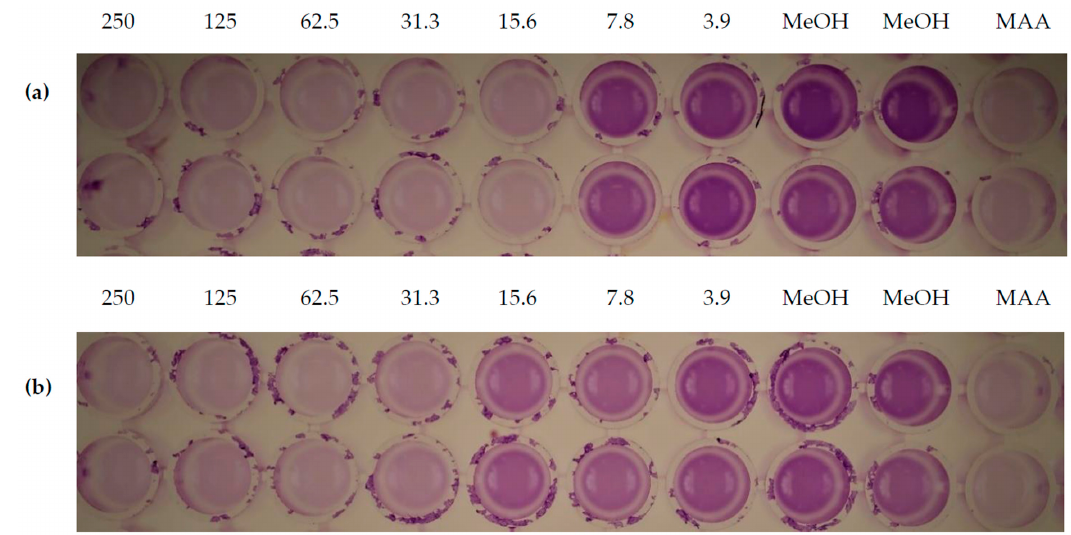
Figure 5. Inhibition of the biofilm formation in S. aureus of compounds 5 ( a ) and 6 ( b ). Each column has two replicates in di ff erent concentrations of the compounds (250, 125, 62.5, 31.3, 15.6, 7.8 and 3.9 µ g / mL) and their respective controls. MAA: microporenic acid A (positive control), MeOH: methanol (negative